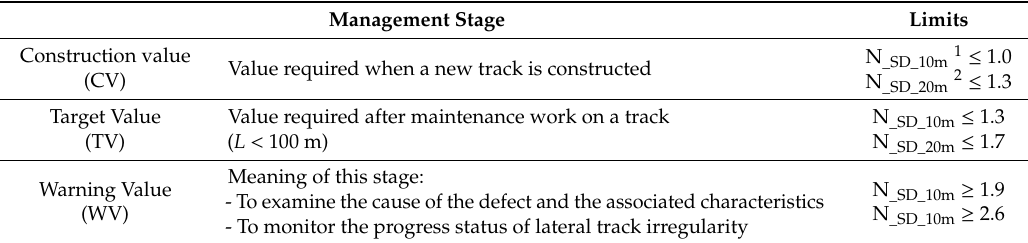
Table 6. Track irregularity management